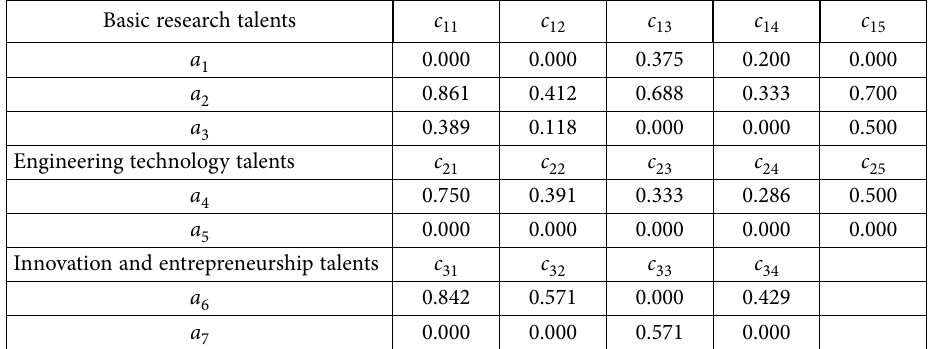
Table 6. The normalization values of alternatives under different criteria Basic research talents c